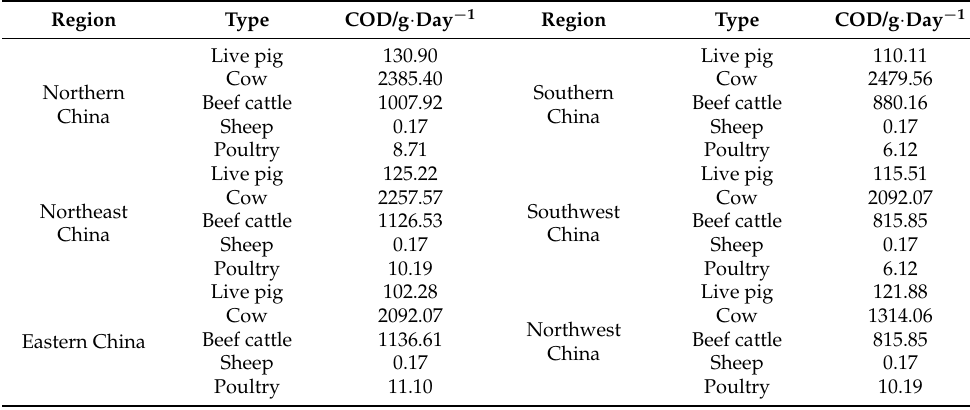
Table 1. COD emission parameters of main livestock species in different